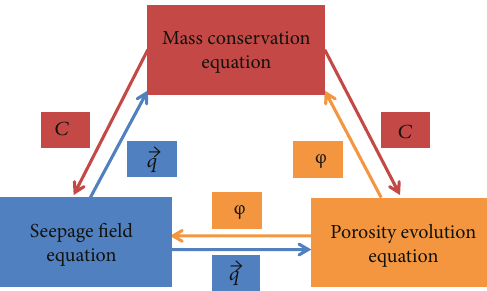
Figure 3: The coupling diagram of each